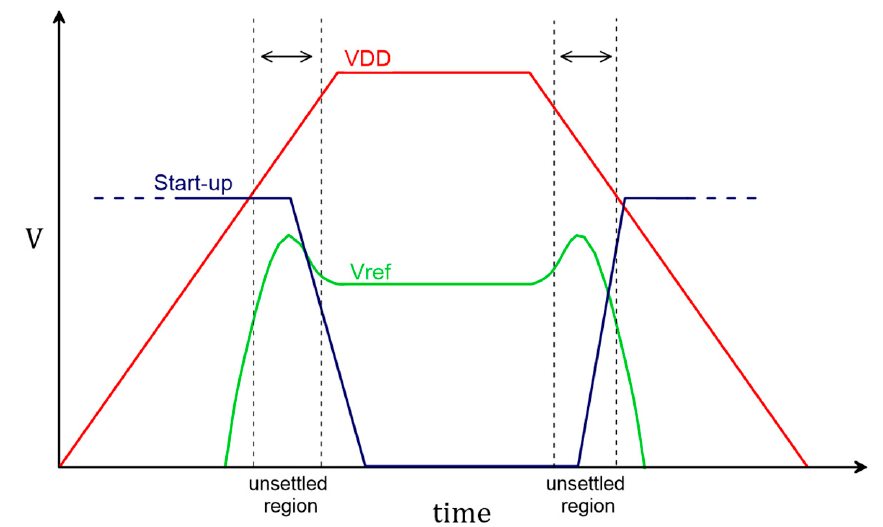
Figure 1. Vref and start-up during power-up and power-down.